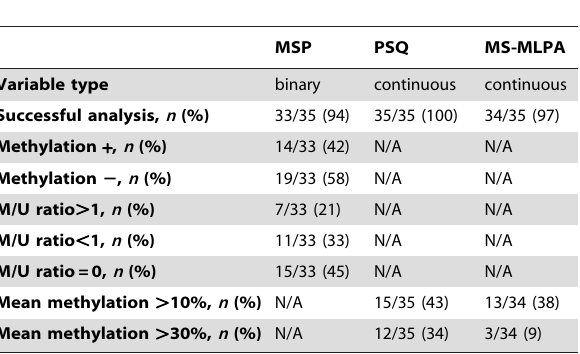
Table 1. Results of MGMT promoter methylation assessed by MSP (qualitative, + / 2 , and semi-quantitative, M/U ratio), PSQ and MS-MLPA.